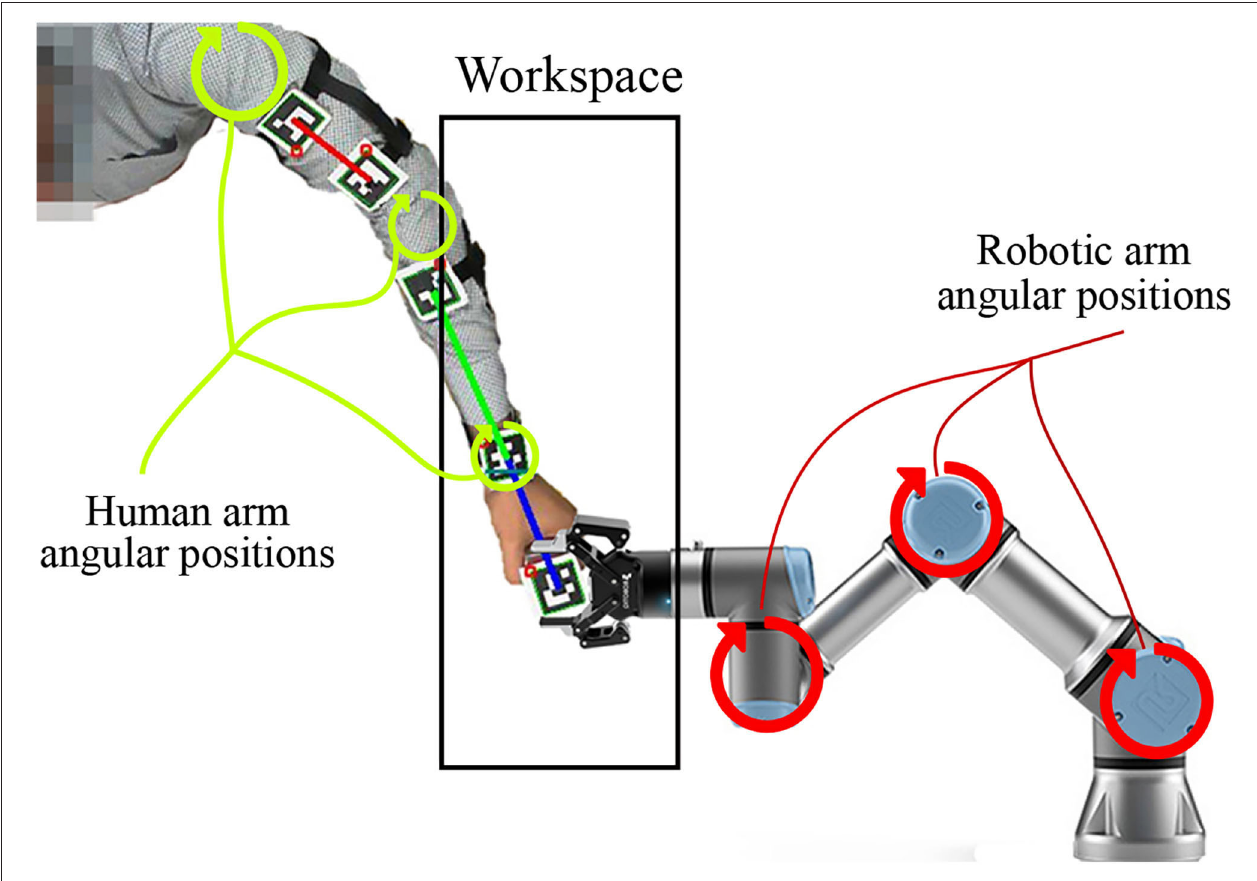
FIGURE 1 | The robotic manipulator and human arm sharing the same end effector position and jointly moving during motor babbling to provide a proper training